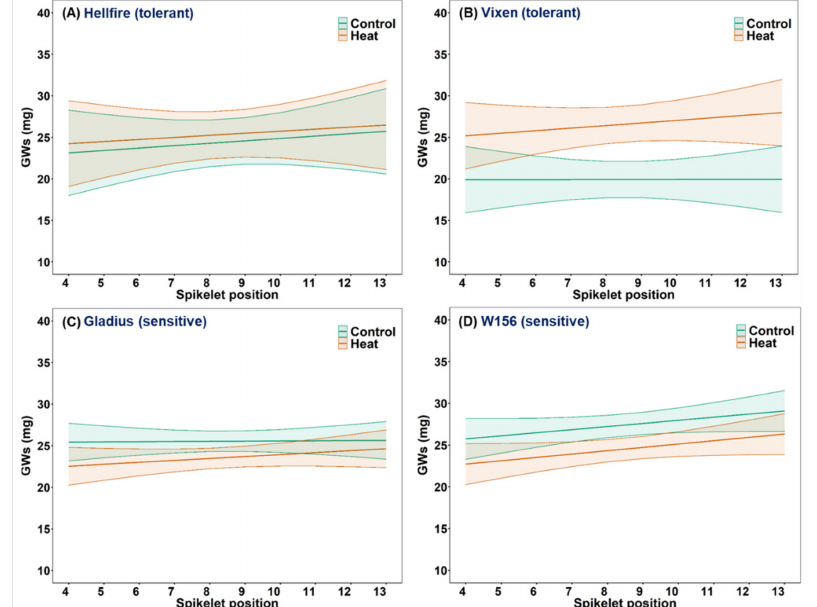
Figure 6. Impact of heat stress on average individual grain weight per spikelet (GWs) at different spikelet positions on the main spike in ‘tolerant’ wheat cultivars, ( A ) Hellfire and ( B ) Vixen, and ‘sensitive’ cultivars, ( C ) Gladius and ( D ) W156. The graphs show the regression lines (95% confidence interval) of the linear model for GWs against spikelet position (4 to 13) following control and high temperature treatments at meiosis. Refer to Supplementary Table S5 for further